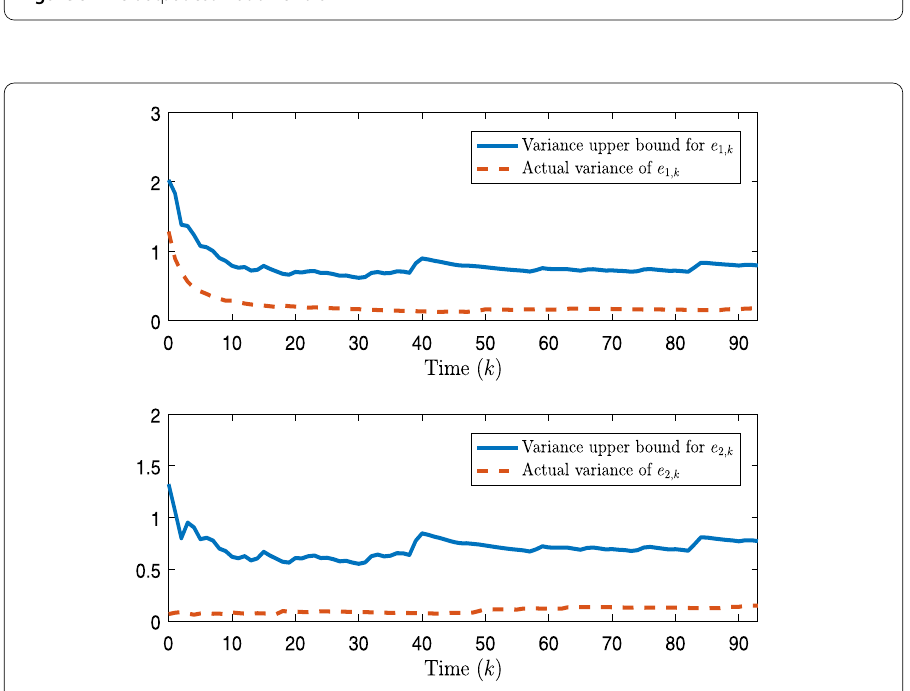
Figure 3 The output estimation errors